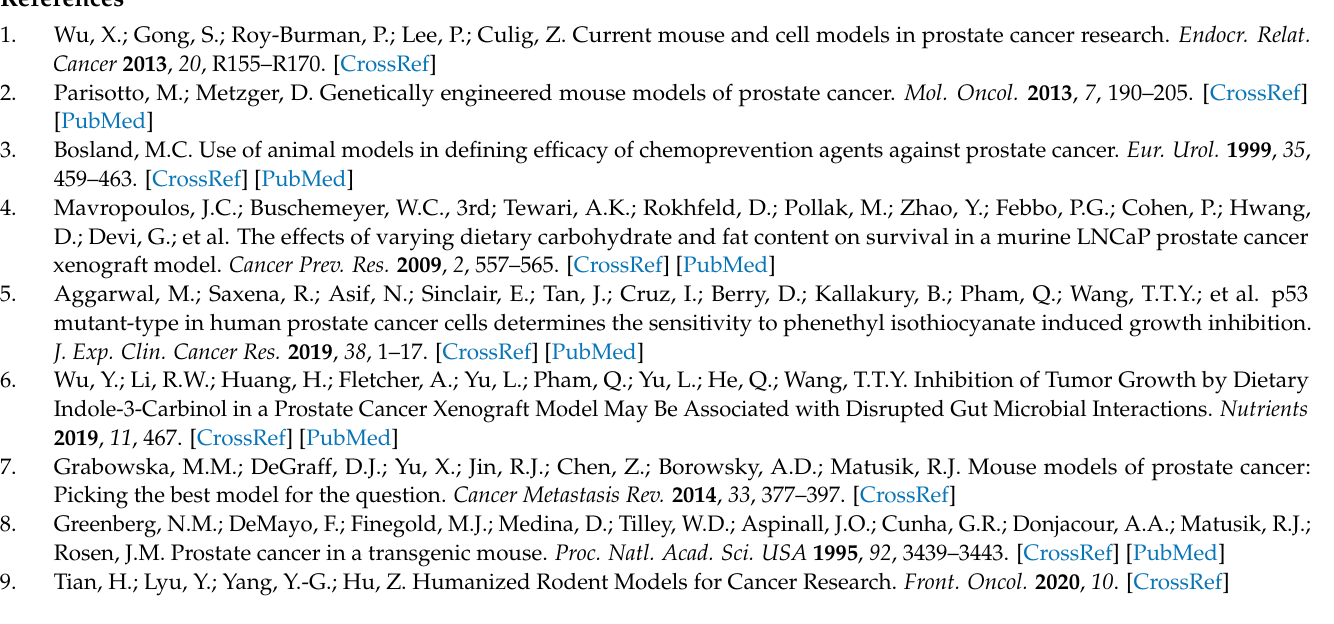
Supplementary Materials 1: IPA gene list, Supplementary Materials 2: IPA top canonical pathway, Supplementary Materials 3: IPA networks, Supplementary Materials 4: IPA upstream regulator, Supplementary Materials 5: IPA causal